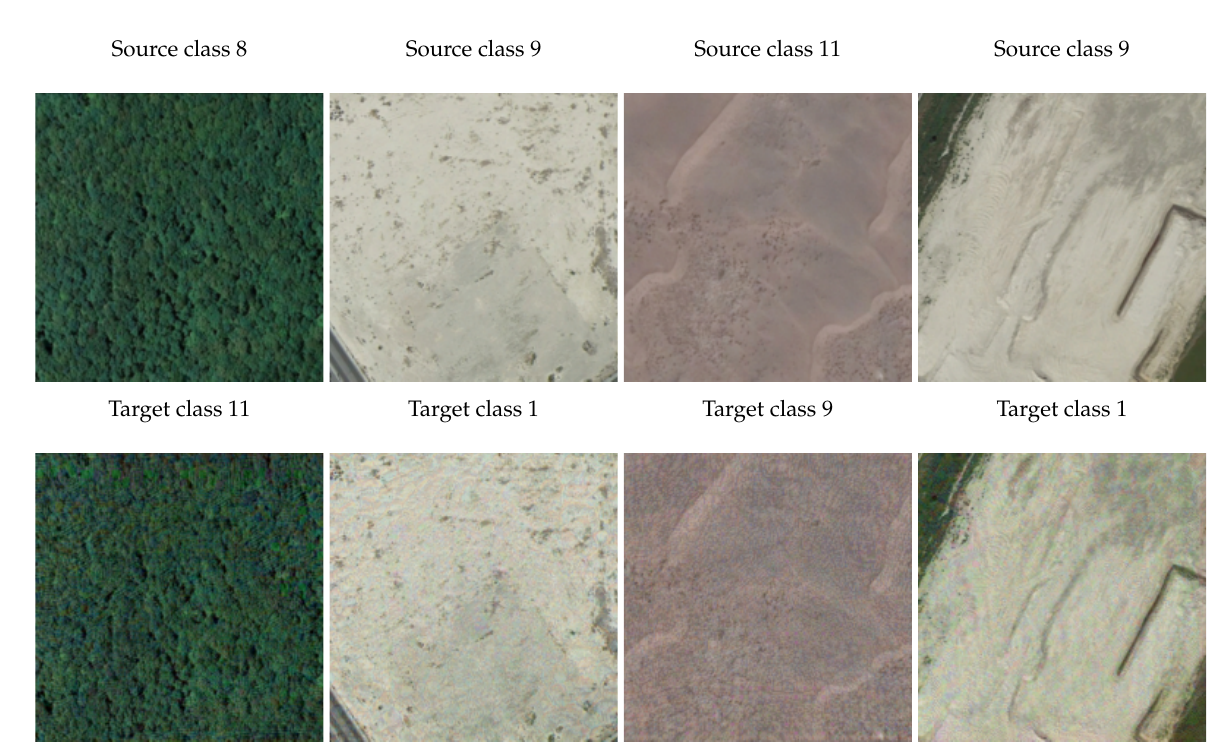
Figure 4. Samples of source-targeted universal adversarial examples on AID. The upper row shows the images from source classes, while the lower row shows the corresponding targeted adversarial examples, misleading the victim models to predict the target classes.